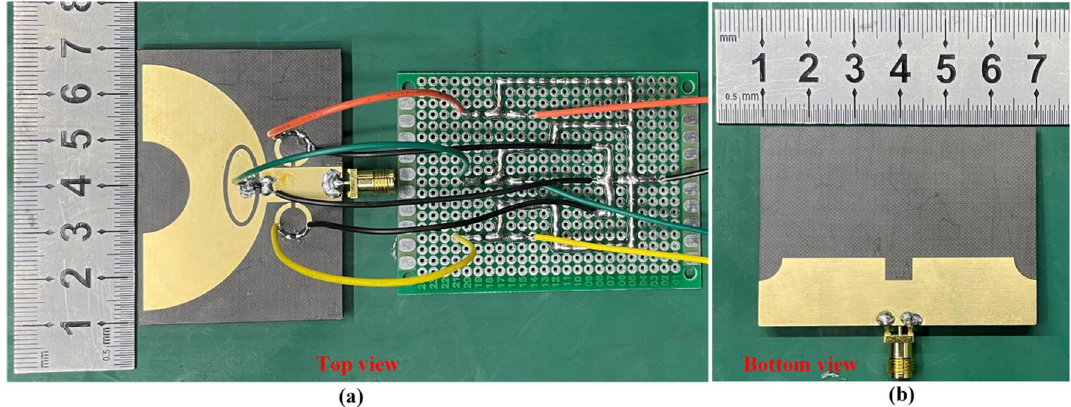
Figure 7. Fabricated prototype of antenna with its ( a ) top and ( b ) bottom view.